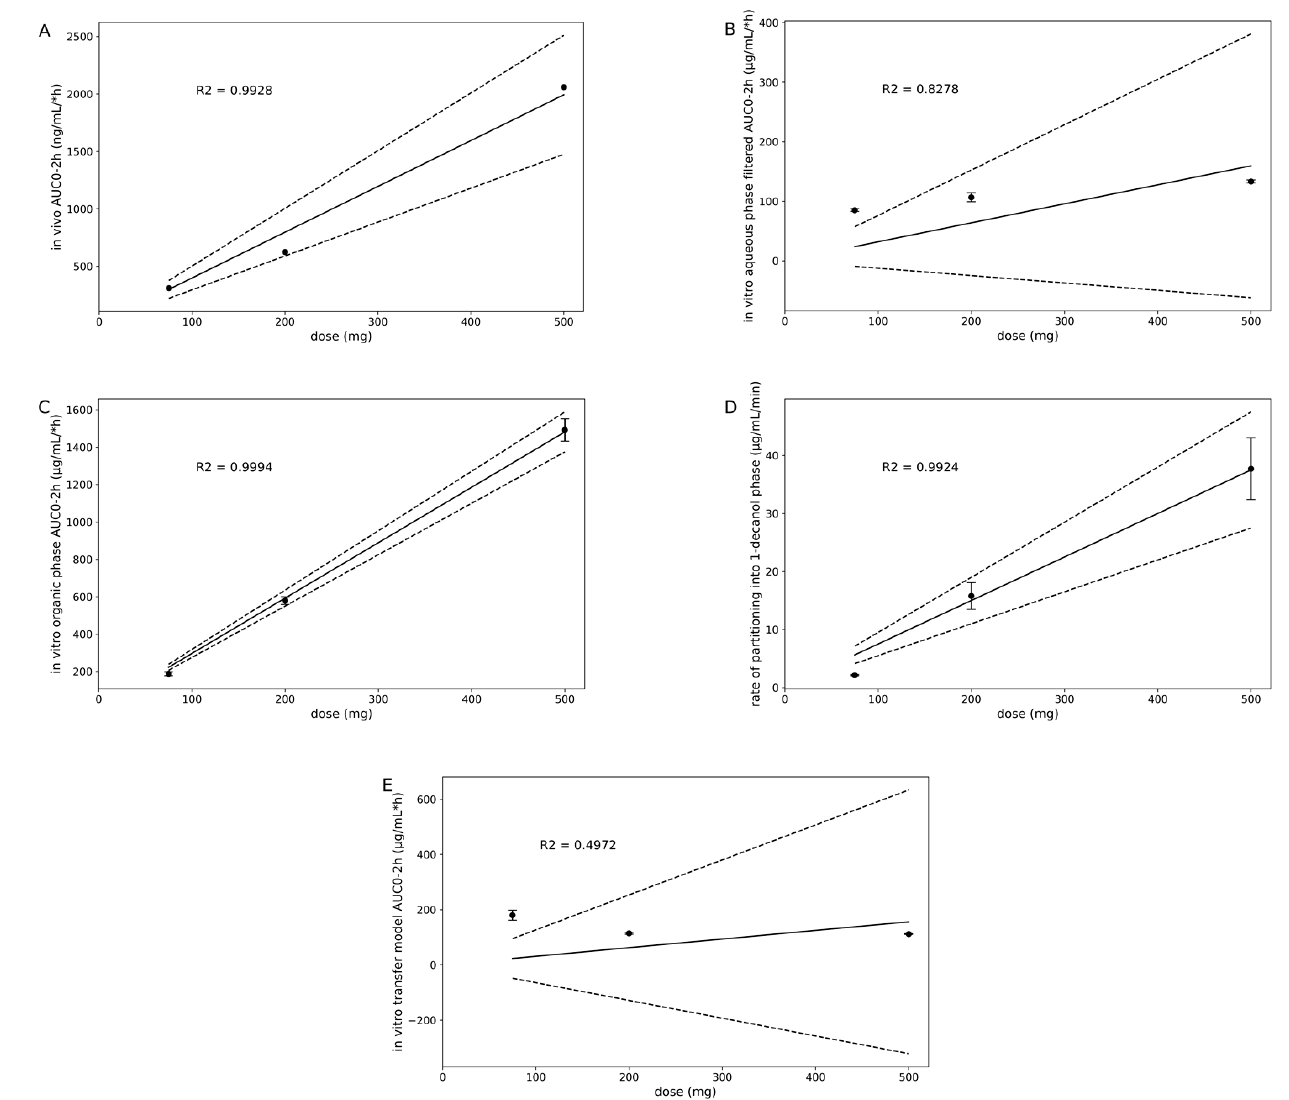
Figure 7. In vivo area under the plasma concentration-time curve of 75, 200, and 500 mg MSC-A as OS during first 2 h (( A )); slope = 3.9849; p = 0.0036). In vitro aqueous phase (( B ); slope = 0.3191; p = 0.0902) and organic phase (( C ); slope = 2.9639; p = 0.0003) area under the drug concentration-time curve during first 2 h, and rate of linear partitioning into organic phase between 7.5 and 20 min (( D );